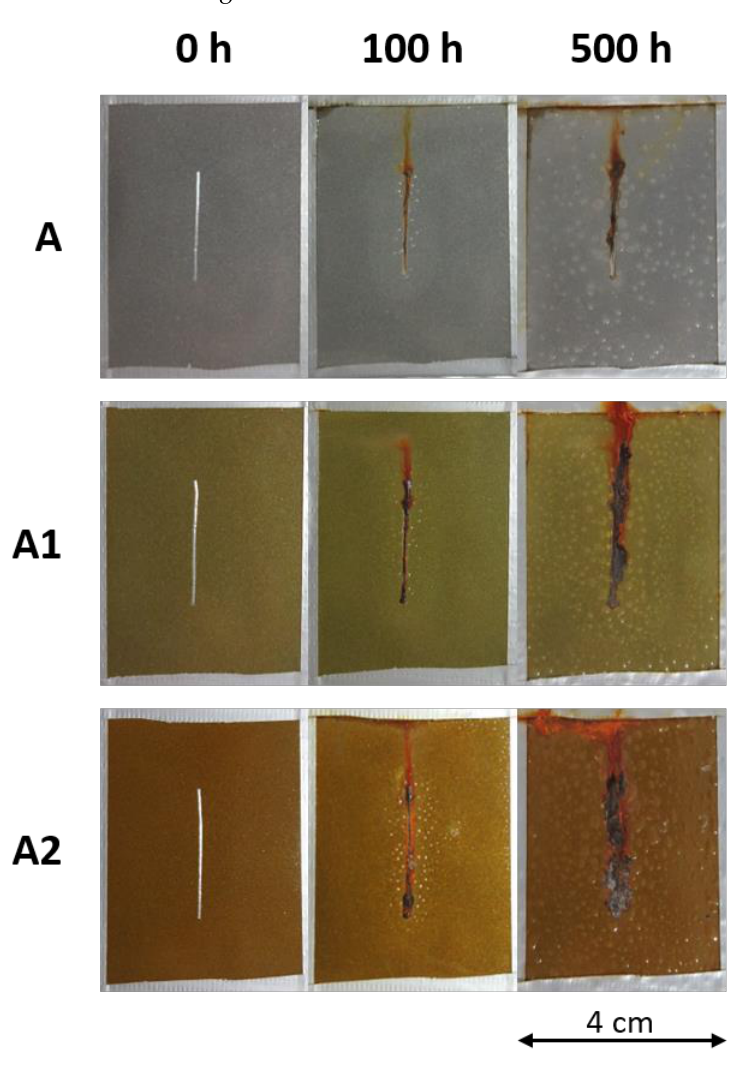
Figure 6. Coating degradation during sample exposure in salt spray chamber.